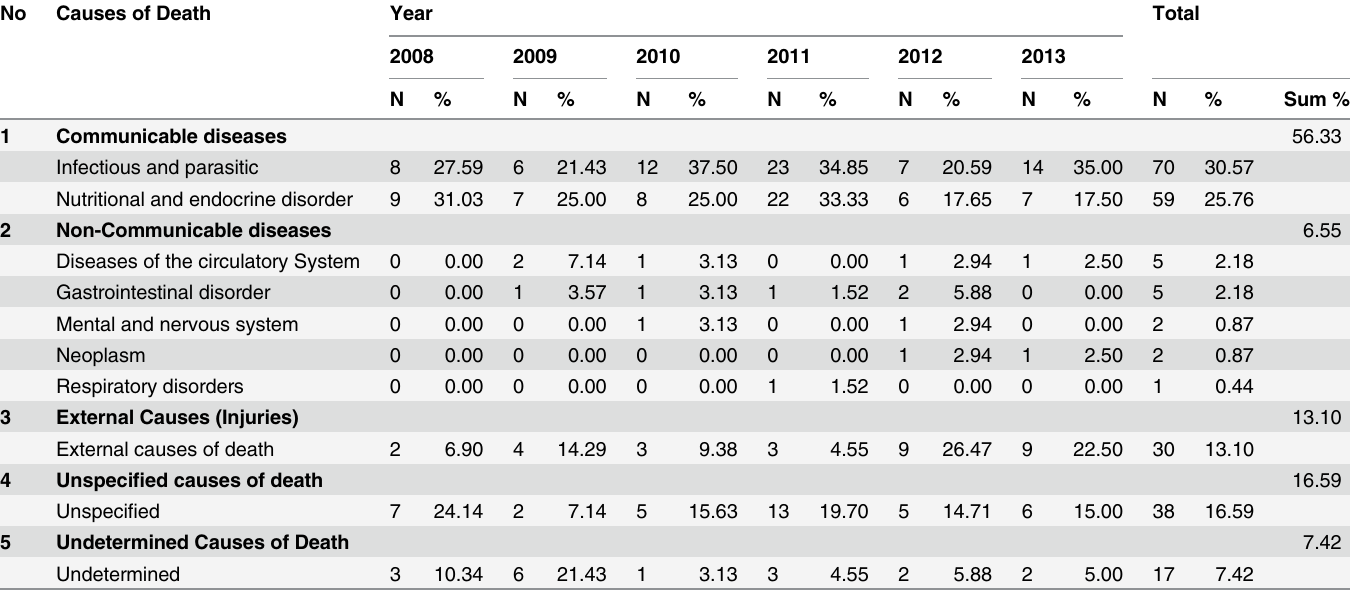
Table 2. Broad causes of death by year among 5 – 14 year old children, Kersa HDSS, 2008 –